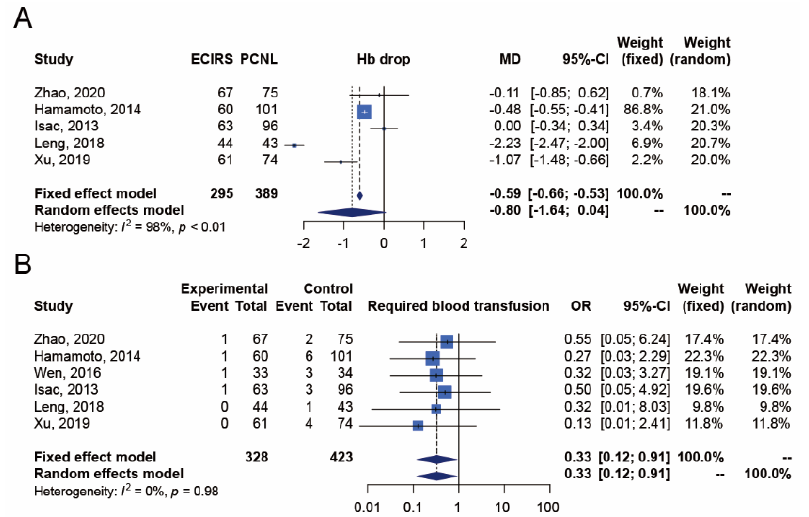
Figure 4. Meta-analysis of bleeding risks, including ( A ) hemoglobin drop [18,19][21–23] and ( B ) re- quired blood transfusion [17–19][21–23] between ECIRS and PCNL groups.